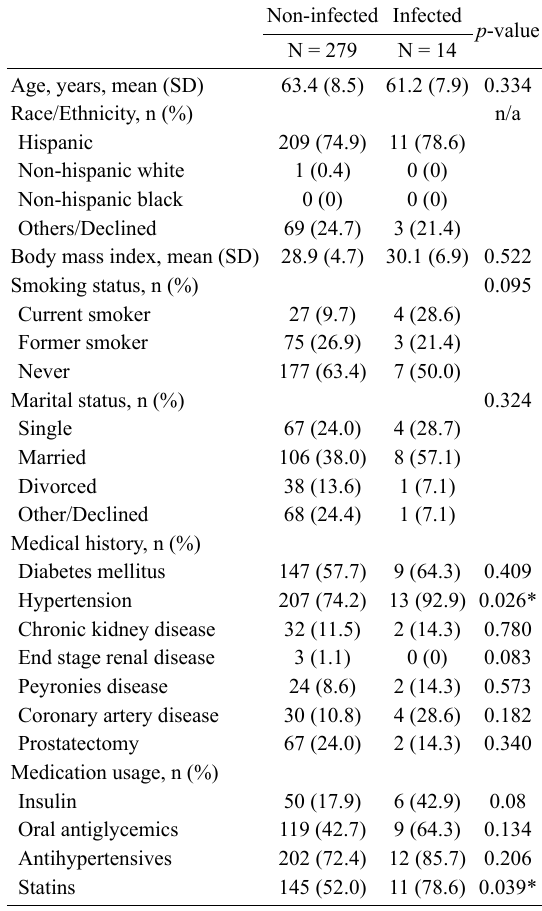
Table 1. Patient demographics and